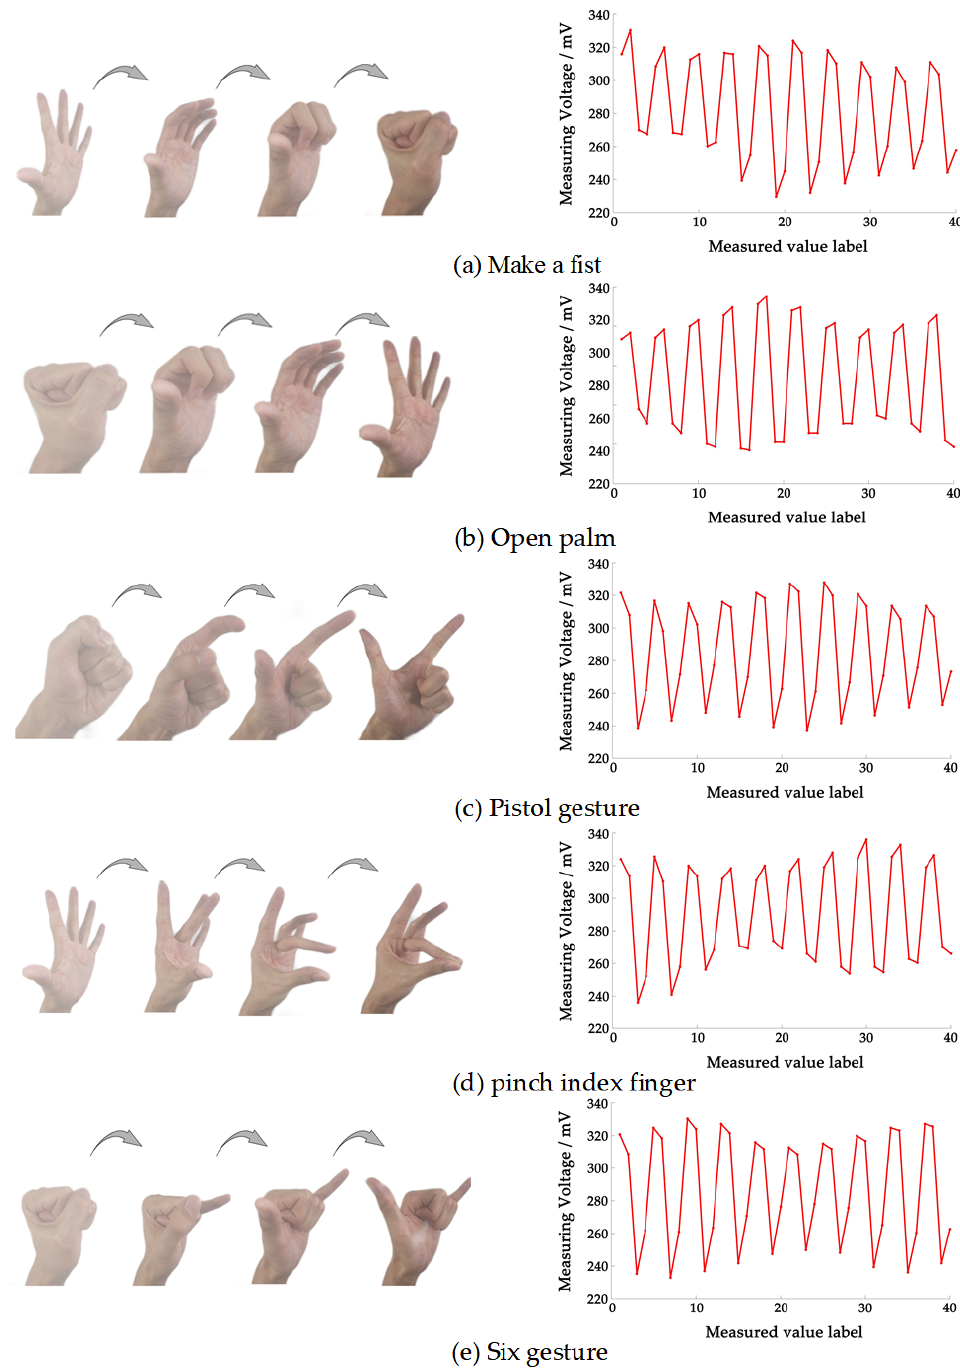
Figure 7. The dynamic gesture set and the measurement results of different gestures. The red solid line represents a measured data sequence for one dynamic gesture, which is composed of 40 measured voltages. The abscissa is the index of measured data, and the ordinate represents the amplitude of the measured voltage.